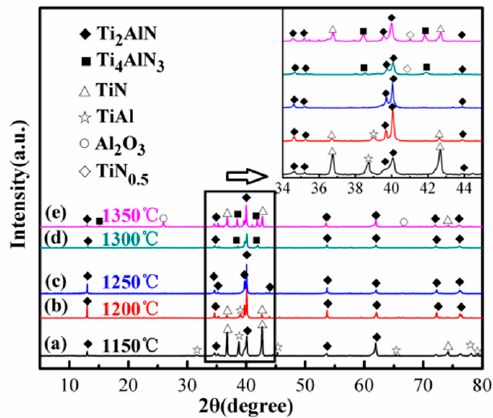
Figure 6. XRD patterns of the 1TiH 2 /1.15Al/1TiN powder system after 30 min of sintering at different temperatures (1150–1350 °C): ( a ) 1150 °C; ( b ) 1200 °C; ( c ) 1250 °C; ( d ) 1300 °C; ( e ) 1350 °C.